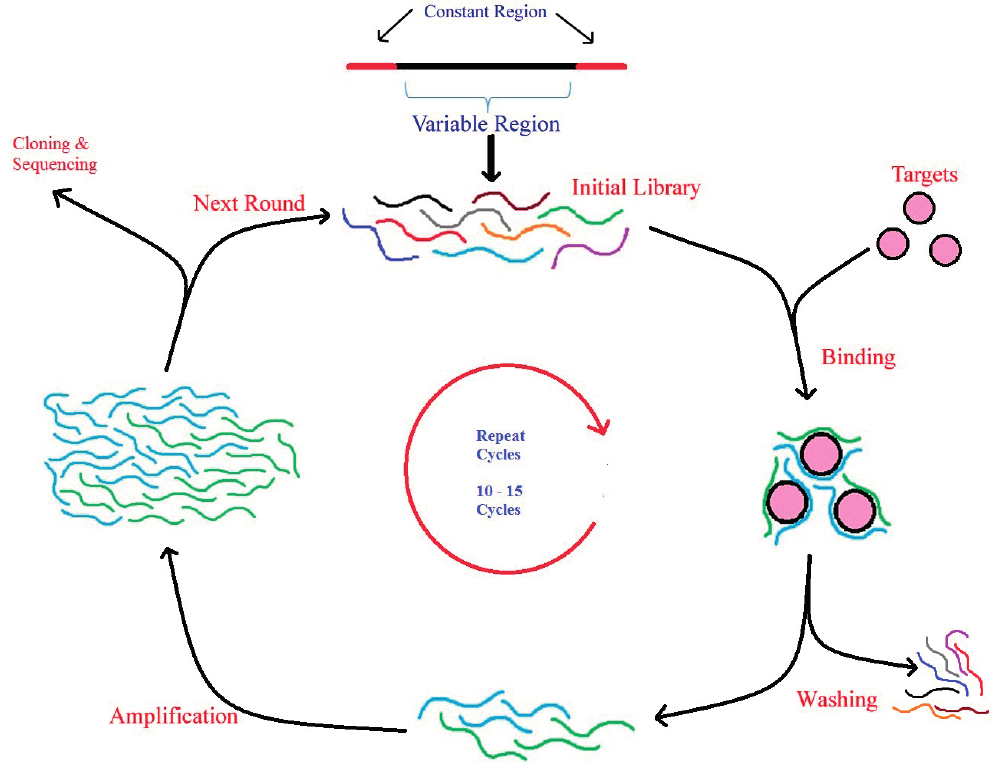
Figure 1. Schematic representation of SELEX process—Oligonucleotide library generation, binding, washing, amplification, cloning and sequencing of